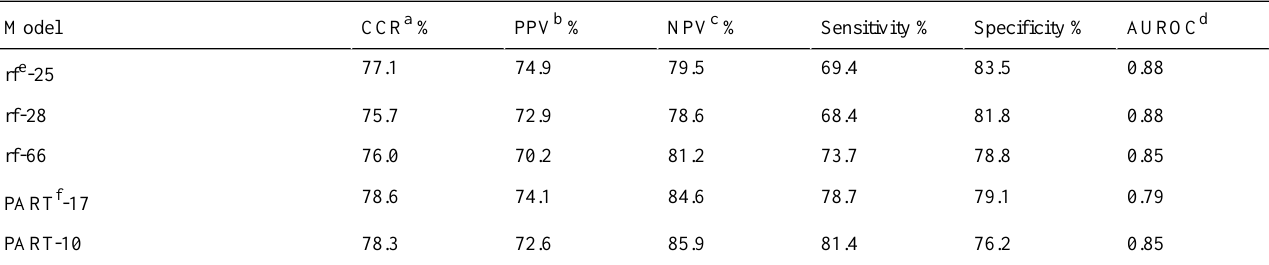
Table 4. Classification accuracy of models included in the ensemble. Results obtained from the analysis of 138 patients without missing values for